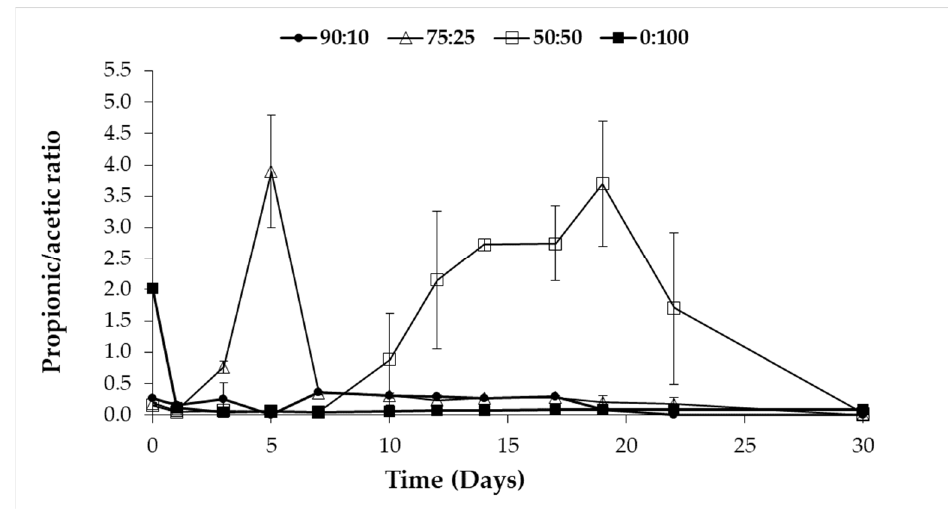
Figure 5. Evolution of the propionic/acetic ratio. The 75:25 and 50:50 mixtures exceeded the value of 1.4 in the propionic/acetic ratio, a value determined as a limit for the correct functioning of the AD process [52]. However, these mixtures reached admissible values over time, recovering the stability of the